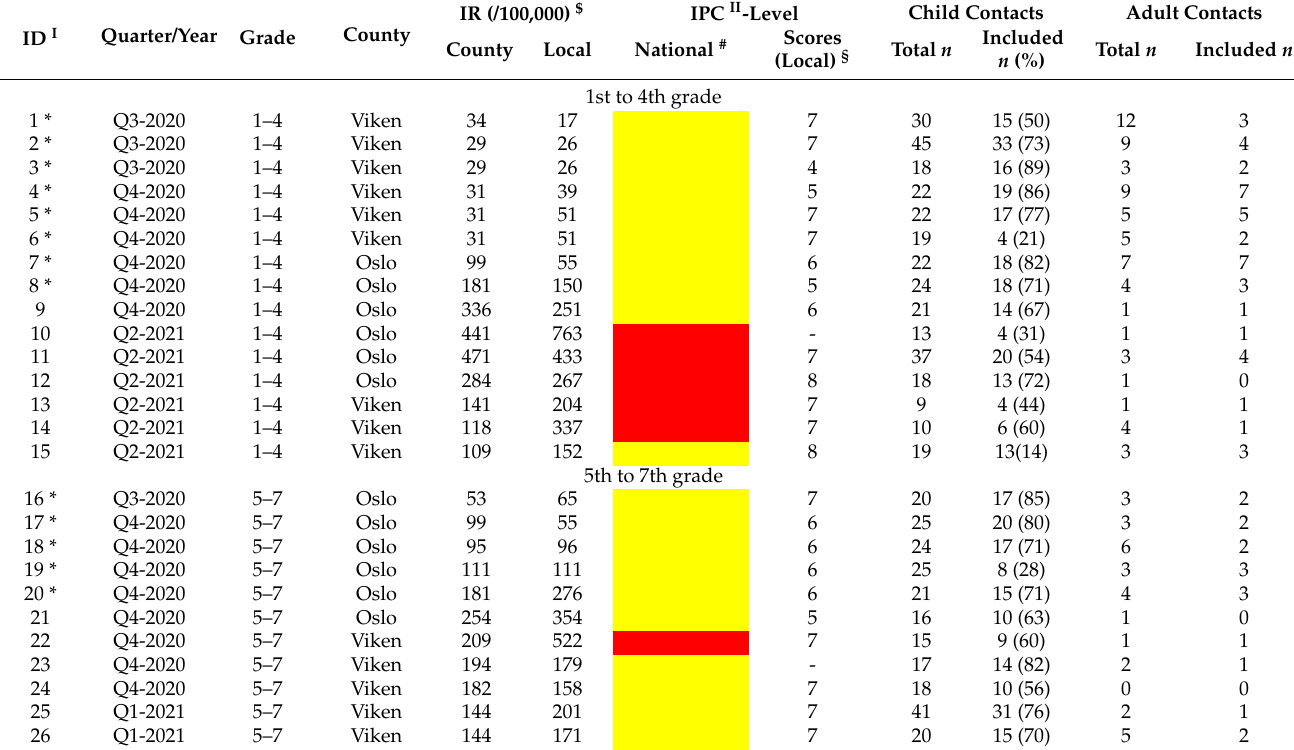
Table A2. Characteristics of the